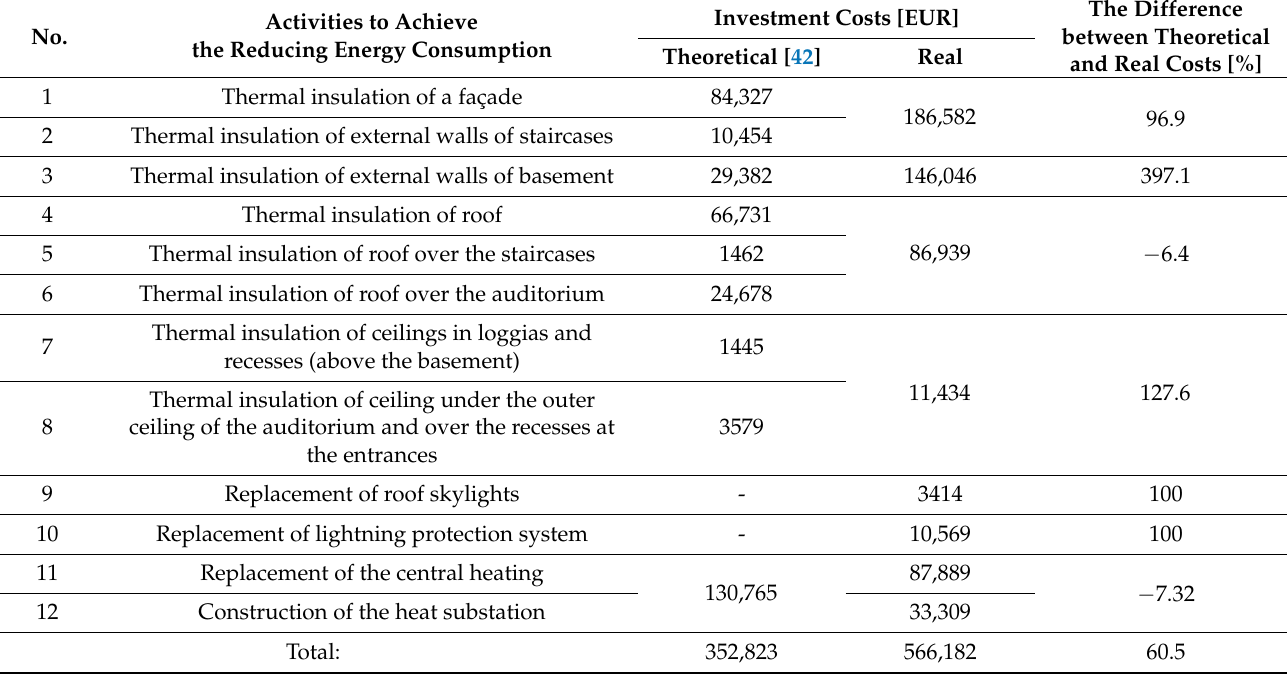
Table 14. Comparison of planned cost in the energy audit and the real costs of the thermomoderniza- tion investment in the analyzed